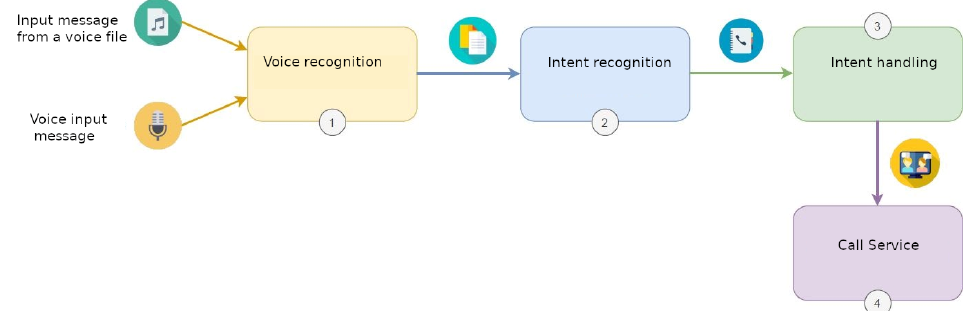
Figure 15. Voice assistant